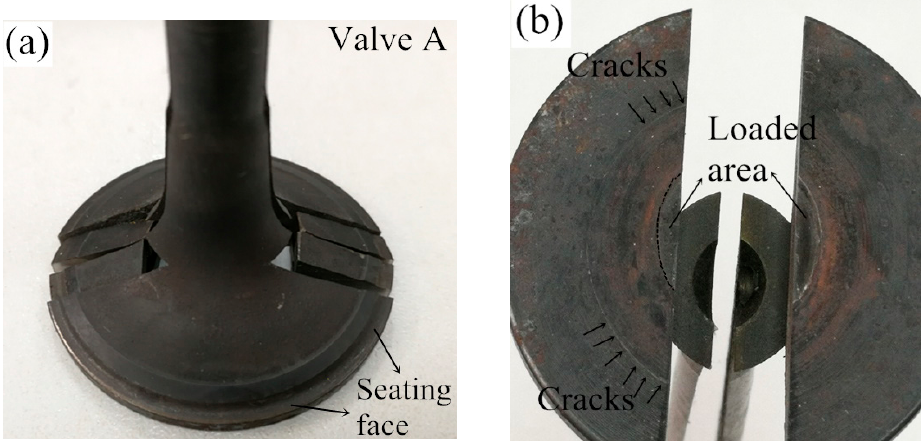
Figure 14. ( a ) Front view of valve A post-test; ( b ) combustion face of valve A